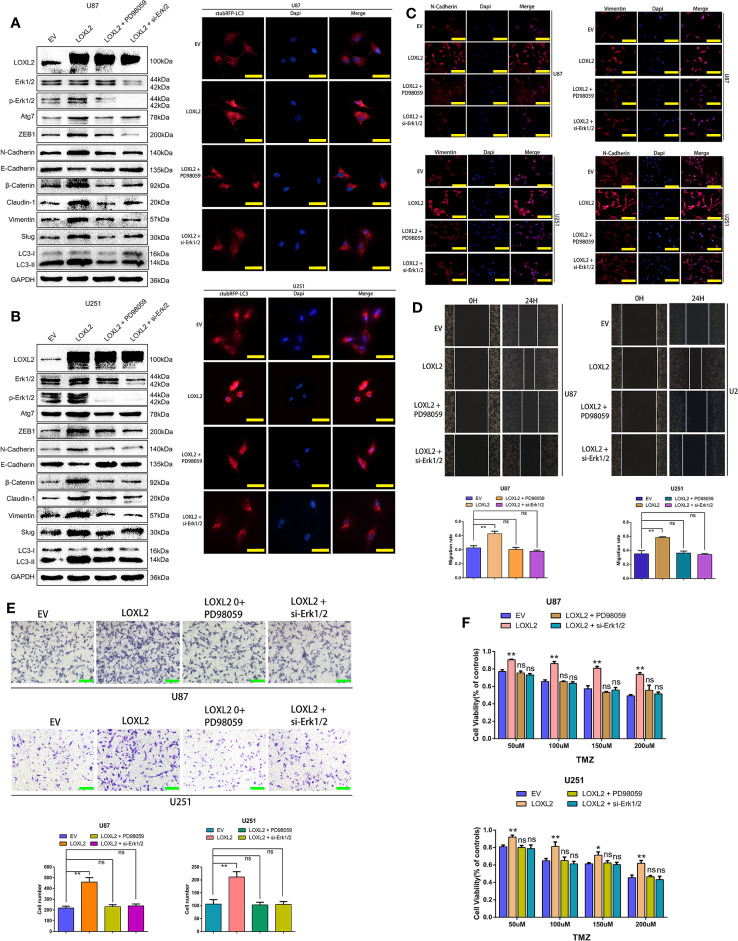
LOXL2 regulated Atg7 expression by promoting Erk1/2 phosphorylation. (A) Protein levels of Erk1/2, p-Erk1/2, Atg7, epithelial-to-mesenchymal transition (EMT)-related markers, LC3-I, and LC3-II in differently transfected glioma cells. (B) Immunofluorescence of stubRFP-LC3 punctuate localization in U87 and U251 cells with EV, LOXL2, LOXL2 + PD98059, and LOXL2 + si-Erk1/2 treatment; scale bar = 40 µm (C) Immunofluorescence was used to assess Vimentin and N-cadherin expression in glioma cells under different transduction conditions; scale bar = 100 µm. (D) Wound healing and (E) Transwell assays of glioma cells for comparison of cell migration and invasion with EV, LOXL2, LOXL2 + PD98059, and LOXL2 + si-Erk1/2 treatment; scale bar = 100 µm. (F) Viability of glioma cells with EV, LOXL2, LOXL2 + PD98059, and LOXL2 + si-Erk1/2 with indicated TMZ doses. *P < 0.05; **P < 0.01, ns: P ≥ 0.05.